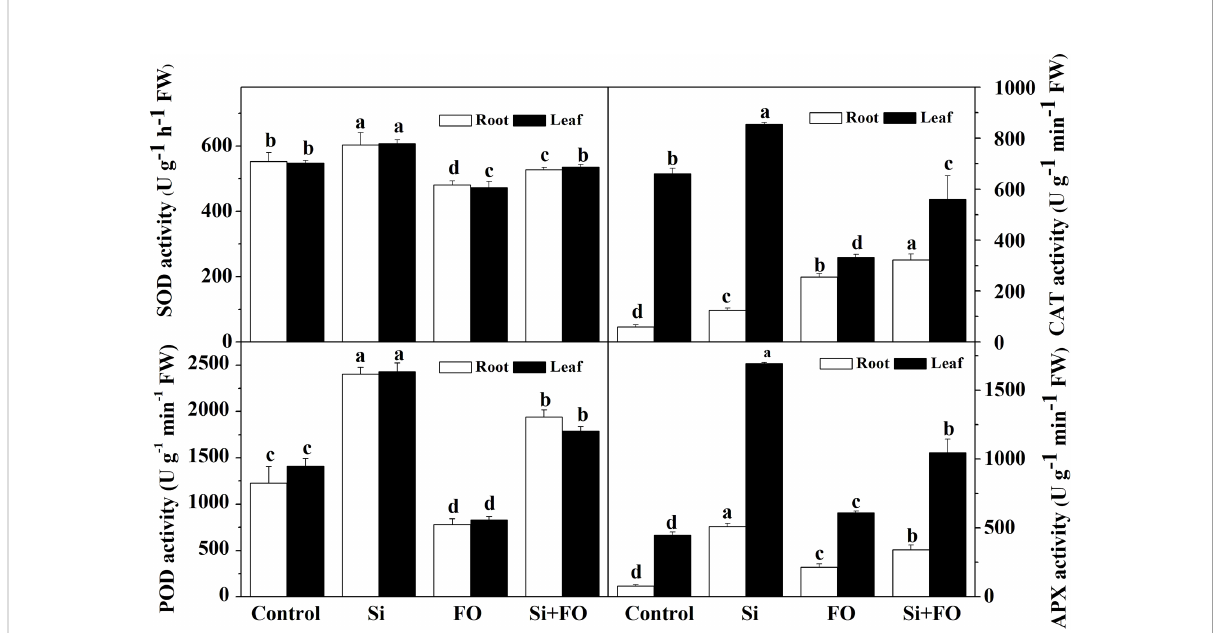
FIGURE 4 Effects of exogenous silicon application on the activities of POD, CAT, SOD, and APX in cucumber roots. Means denoted by the different lowercase letters are signi fi cantly different according to Tukey ’ s test ( P ≤ 0.05); the mean represents the average of three replicates ± standard deviation (SD). Control: plants were irrigated with sterilized water; Si: plants were irrigated with exogenous silicon (3 mmol·l -1 Si); FO: plants were only inoculated with Fusarium ; Si+FO: plants were irrigated with exogenous silicon followed by inoculation with Fusarium.